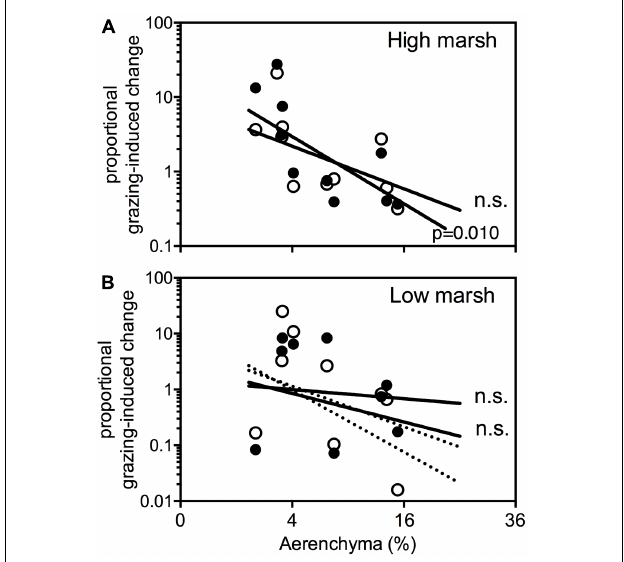
FIGURE 5 | Proportional grazing-induced plant cover change per species on the high marsh (A) and low marsh (B) is plotted against the amount of aerenchyma (%). Proportional grazing-induced change is defined as plant cover (%) in presence of large herbivores [cattle ( ) divided by plant cover (%) in absence of large herbivores]. The dotted lines in (B) show the correlations when Tripleurospermum maritima is not taken into account. ns, not